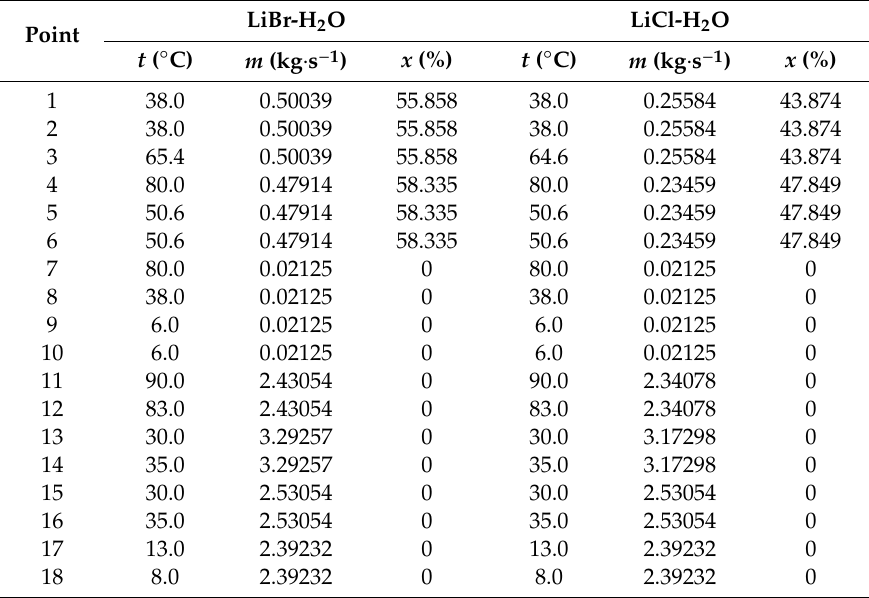
Table 3. Single e ff ect absorption chiller operating parameters.